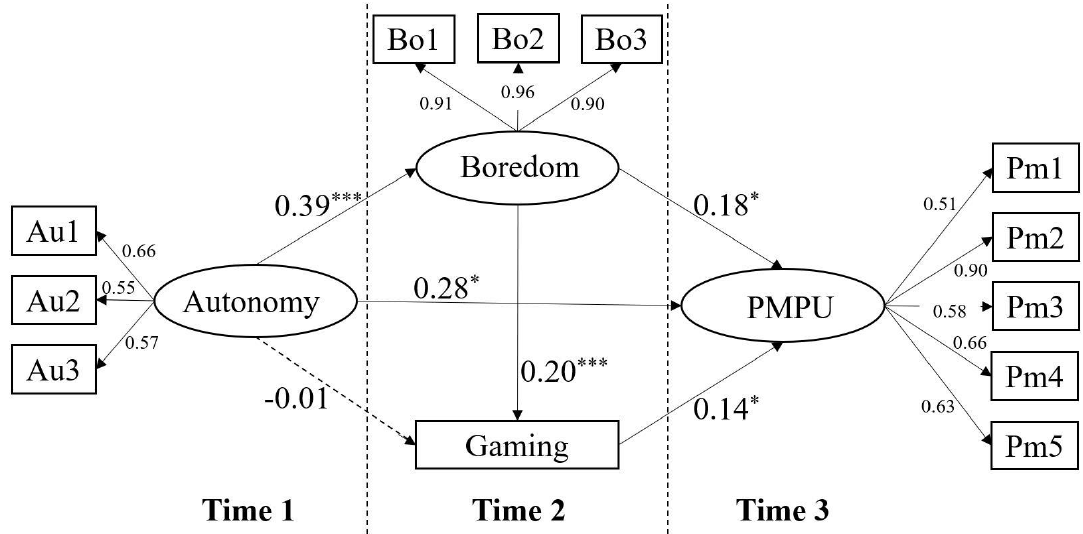
Figure 2. The mediation model of the association between T1 autonomy need dissatisfaction and T3 PMPU. Note. All the loadings on latent variables were significant ( p < 0.001). Autonomy = Autonomy need dissatisfaction, Boredom = Boredom proneness, Gaming = Mobile phone gaming, PMPU = Problematic mobile phone use. * p < 0.05, *** p < 0.001. Table 2. Bias-corrected bootstrap tests on the direct and indirect e ff